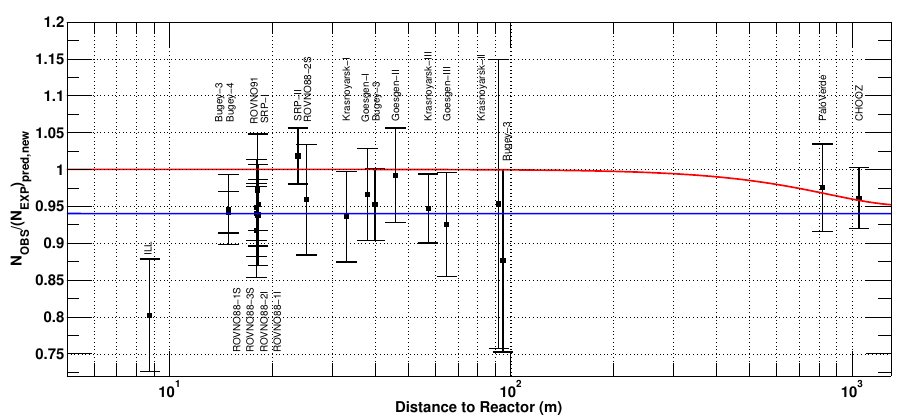
Figure 4: Reactor neutrino flux normalisation as seen in different experiments before the re-evaluation of the fluxes in Refs. [ 14, 15 ] . The blue line is the old prediction, the red line is the new one (including the effect due to non-zero θ experiments have consistently measured fluxes in accordance with the old calcula- tions.